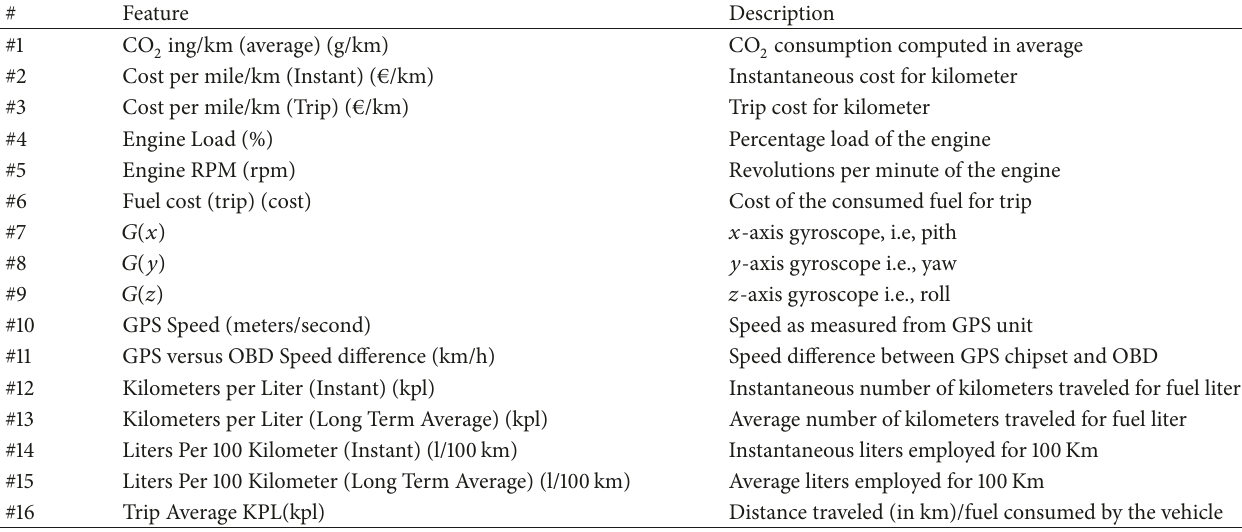
Table 1: Features involved in the study with the relative description and features source (i.e., a feature extracted by the OBD connector or gathered by the device